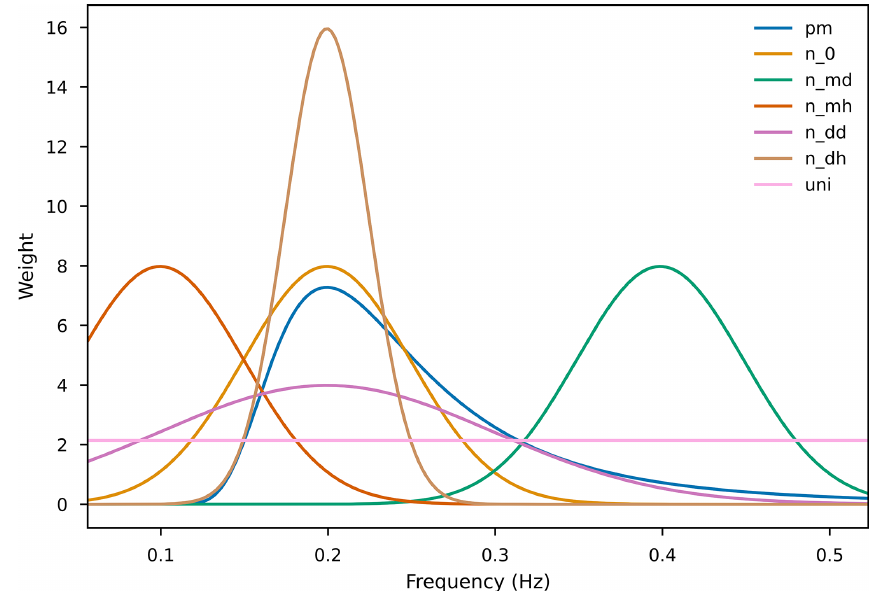
Figure B1. Representation of functions used as alternative weights. They are all normalised on the positive real half-line; because of the finite range of frequencies supported by our model, truncations imply that some of them integrate to less than unity. Description of the legend entries can be found in Table B1.